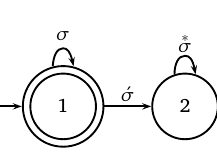
Figure 3: The residue of Amele’s Strictly Piecewise